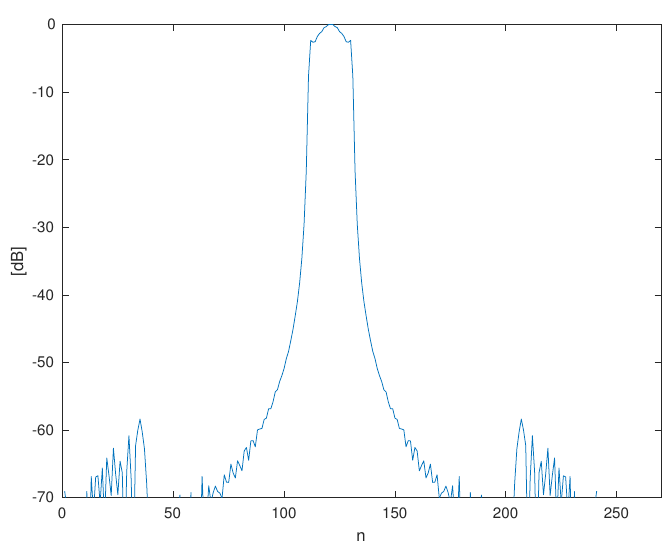
Figure 10. Amplitude of the spectrum of the reduced near field.